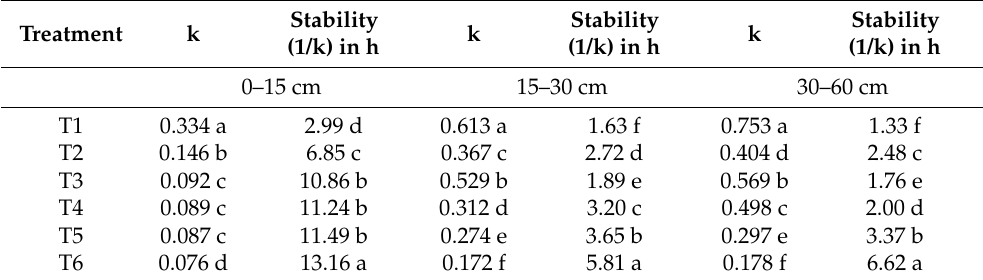
Figure 3. Relationship between C stability in clay–organic complex (COC) and large macroaggregate (LMA) concentration ( n = 18; p ≤ 0.05). Table 1. Effect of different organic amendments on the stability of clay–humus at 0–15, 15–30 and 30–60 cm soil depths under rice–wheat cropping system (k= humus desorption rate constant; while (1/k) = stability in hour (h)).